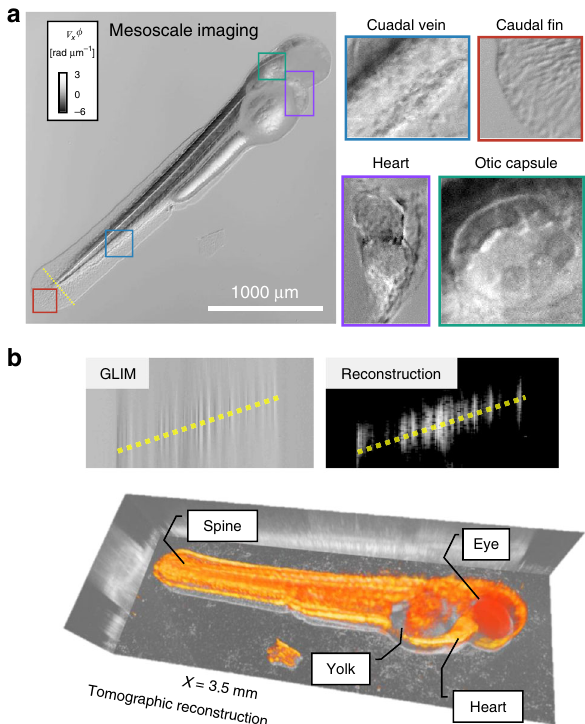
Fig. 6 Epi-GLIM for quantitative phase imaging of whole animals. a QPI tomogram of a free-swimming larval zebra fi sh 6 days post fertilization (×5/0.13) with highlighted organ scale structures. b Tomographic reconstruction was performed using slice-by-slice high-pass fi ltering. Due to absorption, the eye reveals a random phase signal, which we replaced with a constant value, for visualization OCT 10 and the oblique back-illumination microscopy 8 the goals of imaging bulk tissues. Compared to OCT, epi-GLIM uses a sensitivity. The phase shifting approach allows epi-GLIM to suppress multiple scattering and image with coherent fi elds,